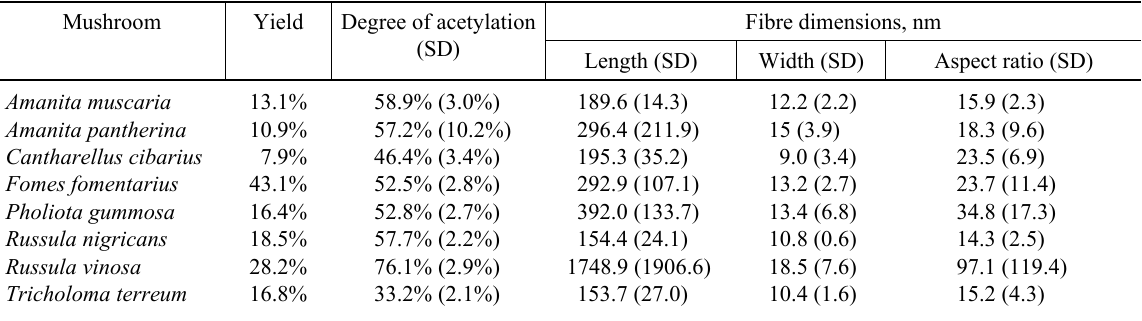
Table 1. Reaction details and fibre dimensions with standard deviation (SD)